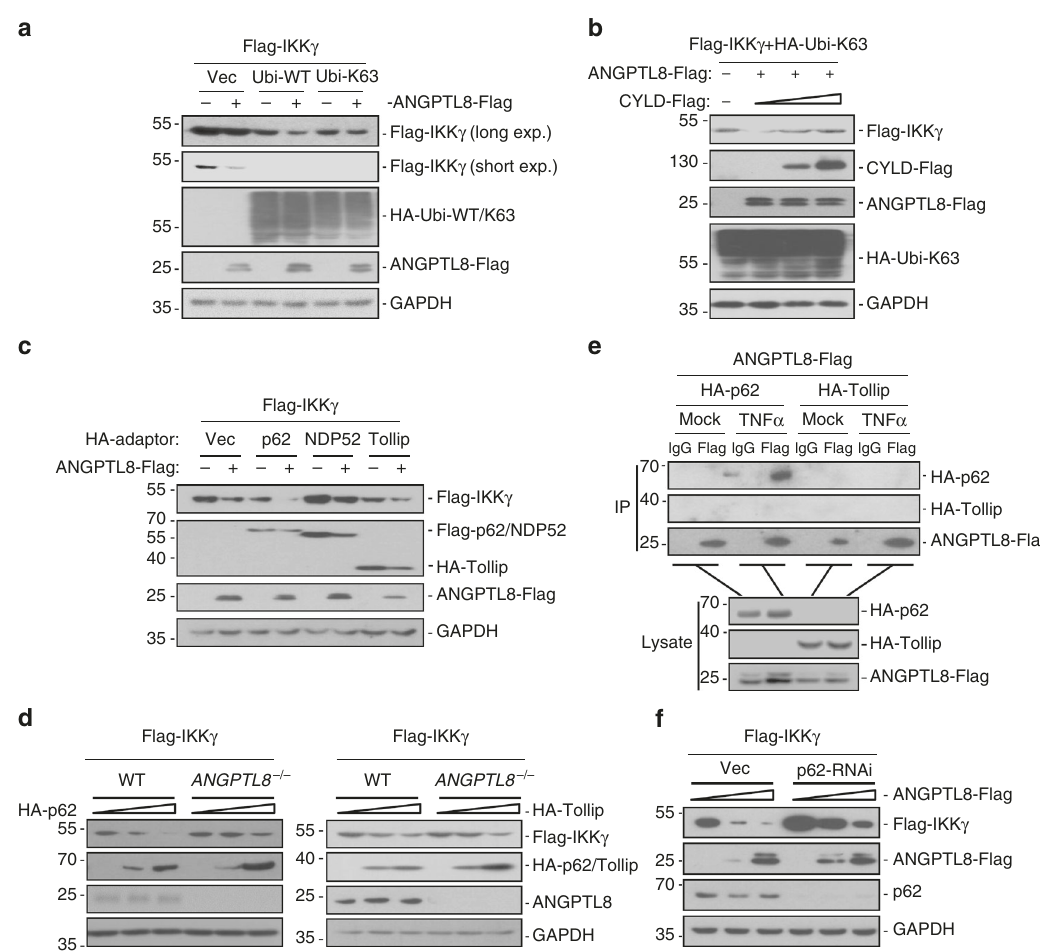
Fig. 7 ANGPTL8 and p62 collaboratively mediate the autophagic degradation of IKK γ . a The effects of ubiquitin on the ANGPTL8-mediated IKK γ degradation in HEK293T cells. Ubi-WT, the wild-type ubiquitin; Ubi-K63, the ubiquitin in which all of lysine (K) mutated to arginine (R) except K63. b The effect of deubiquitinase CYLD on the ANGPTL8-mediated IKK γ degradation. c The effects of different autophagic adaptors on the ANGPTL8-mediated IKK γ degradation. d Overexpression of p62 but not Tollip-mediated IKK γ degradation is attenuated in ANGPTL8 − / − cells. e ANGPTL8 interacts with p62 but not Tollip in the mammalian overexpression system. f ANGPTL8-mediated IKK γ degradation is decreased in p62-RNAi stable cell line. Data